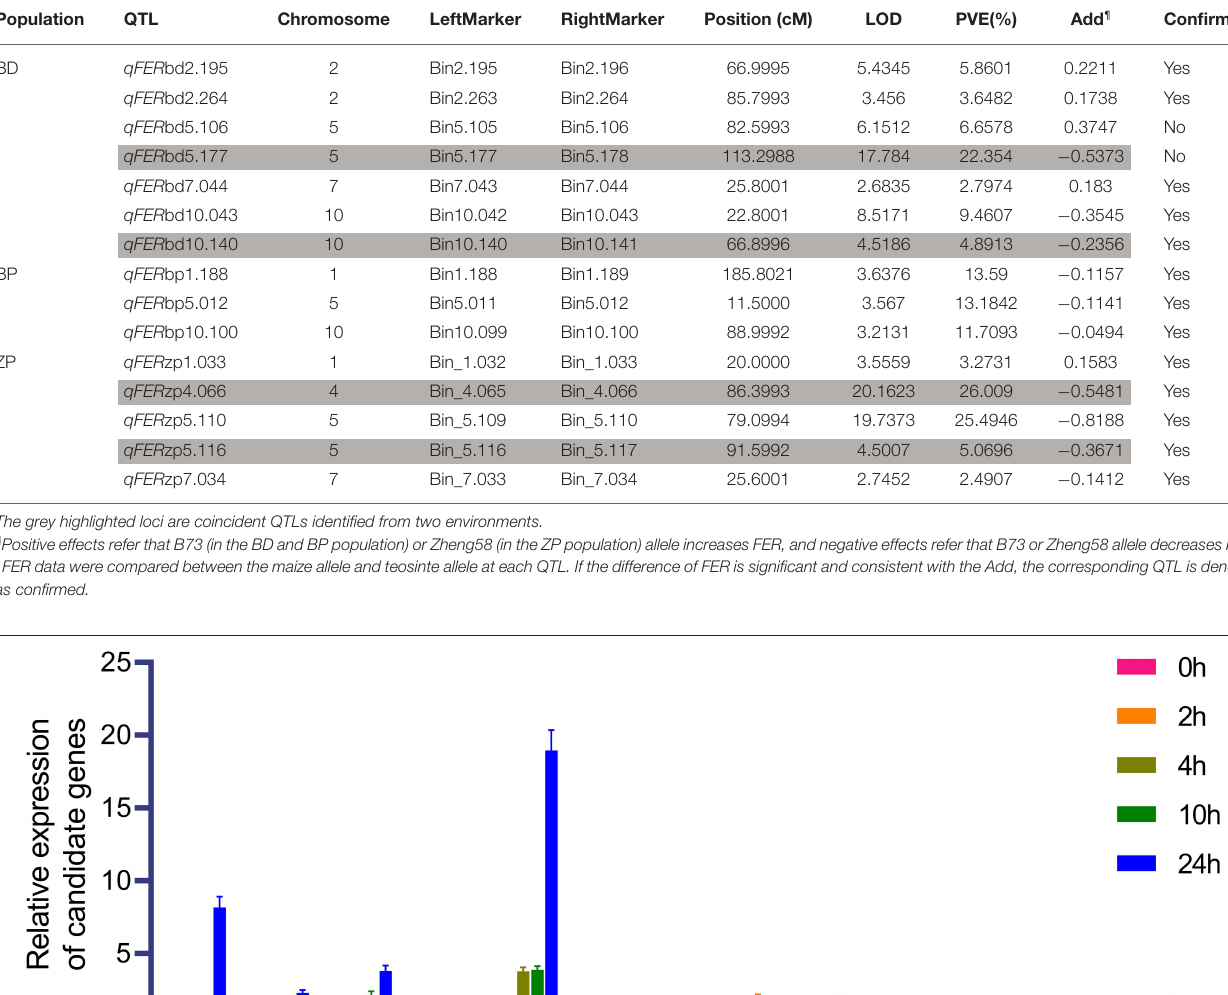
FIGURE 5 | DTS, day to silking; EPP, ear number per plant; SYPP, standard yield per plant; SPPM, standard production per Mu; AKR, average kernel rate; KNR, kernel number per row; AWC: average water content; STW: standard test weight. PVE, phenotypic variation explained by this QTL. ADD, the estimated additive effect of maize parent at this QTL. (E–G) The difference of FER between two homozygous genotypes of each QTLs. The BLUP value of FER from six replicates in two environments was used for QTL mapping. Both left and right markers were used for difference calculation; and the one with the bigger difference was used to represent the QTL. Dip, diploperennis ; Par, parviglumis. Statistical analysis was performed using Student’s t -test. Asterisks on bar represent the difference is significant (* p < 0.05, ** p < 0.01, *** p < 0.001, **** p < 0.0001). “ns” on bar represents the difference is not significant.